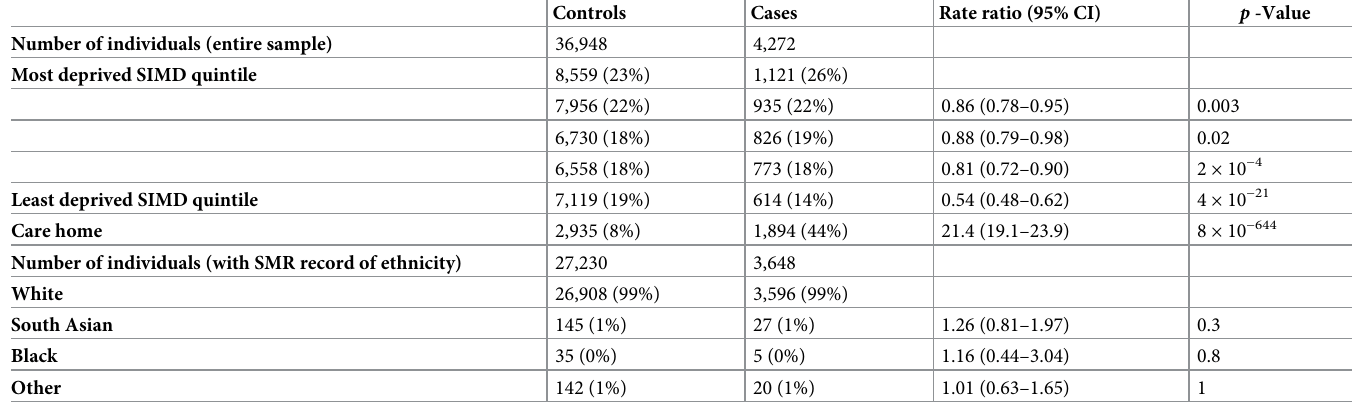
Table 1. Univariate associations of severe disease with demographic factors.